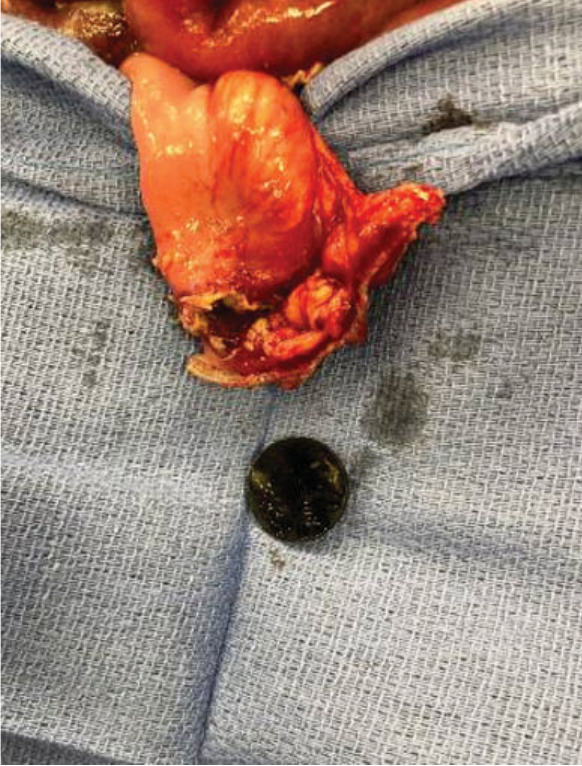
Fig. 2 Intraoperative photo of the 21mm disc battery where it had eroded and perforated the anastomosis. Note the signi fi cant acute and chronic in fl ammation of the